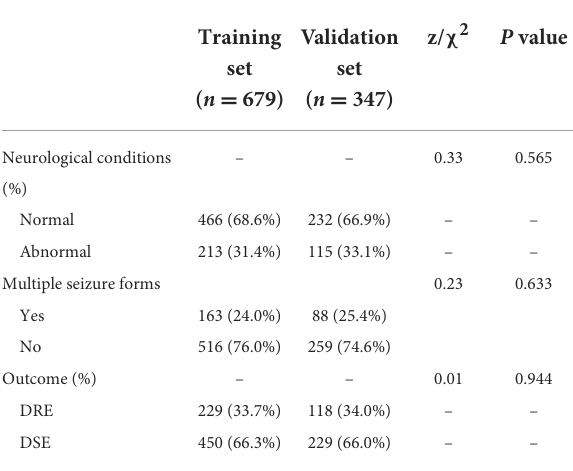
TABLE 1 Baseline characteristics of the training set and validation